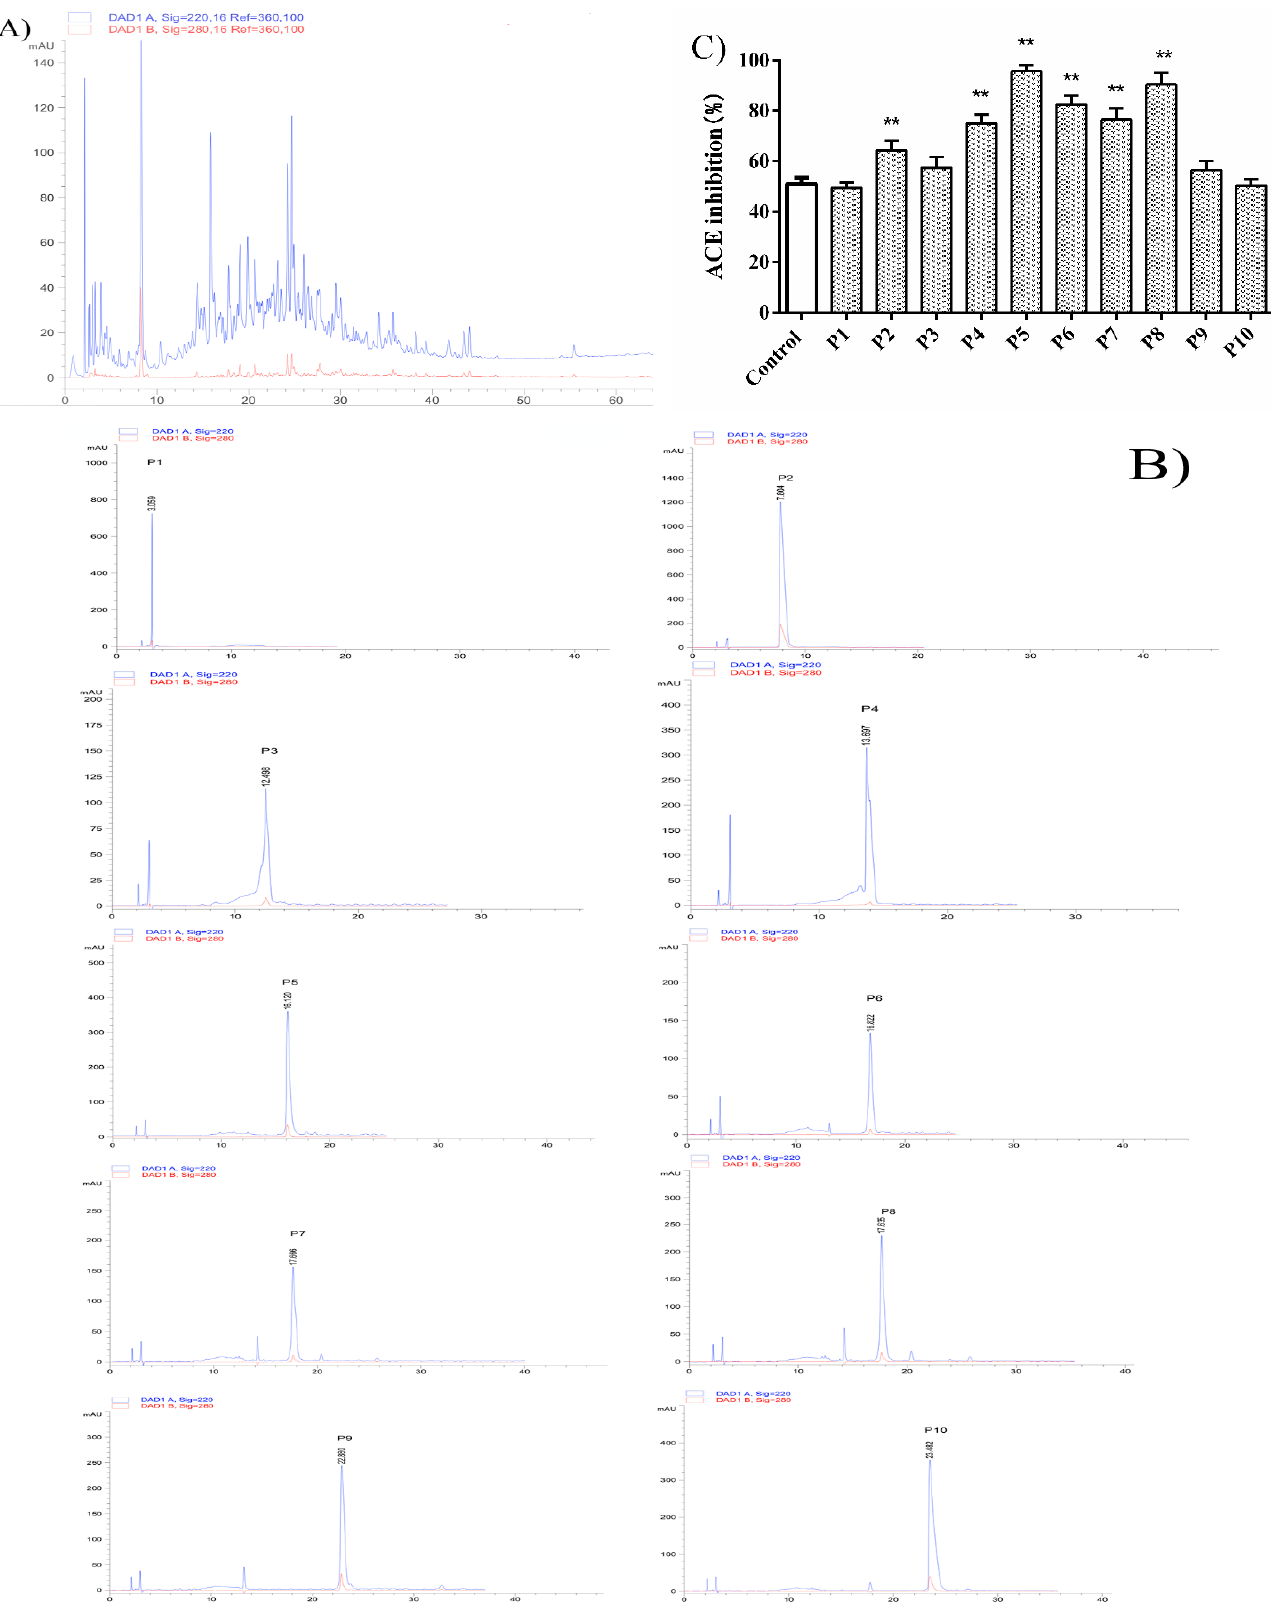
Figure 3. Chromatography of fraction B2 separated by RP-HPLC (Reverse high performance liquid chromatography) on a Shimadzu C18 column (5 µ m, 4.6 × 250 mm) using a linear gradient of acetonitrile (20–100% in 0–25 min) in 0.1% TFA at a flow rate of 1.0 mL/min ( A ). Fractions P1-P10 ( B ).